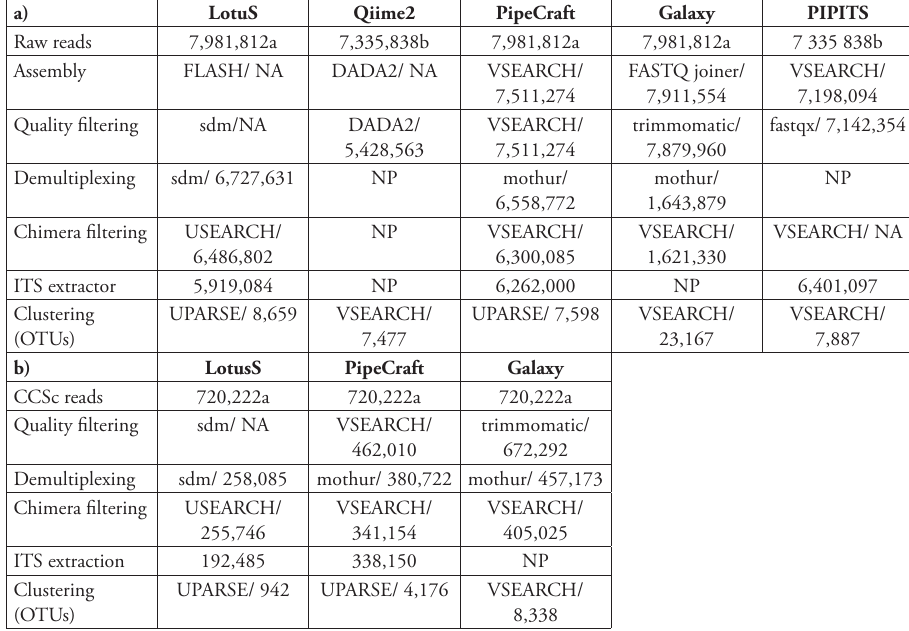
Table 1. Used software, sequence and OTU counts (values in bold) by a ) Illumina and b ) PacBio analysis platforms. The number of sequences denotes raw input reads and remaining reads after each analysis step. Singleton OTUs were excluded from the OTU